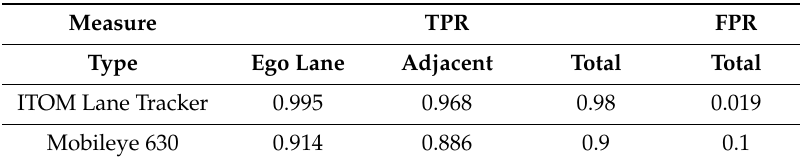
Table 2. Various approaches for lane